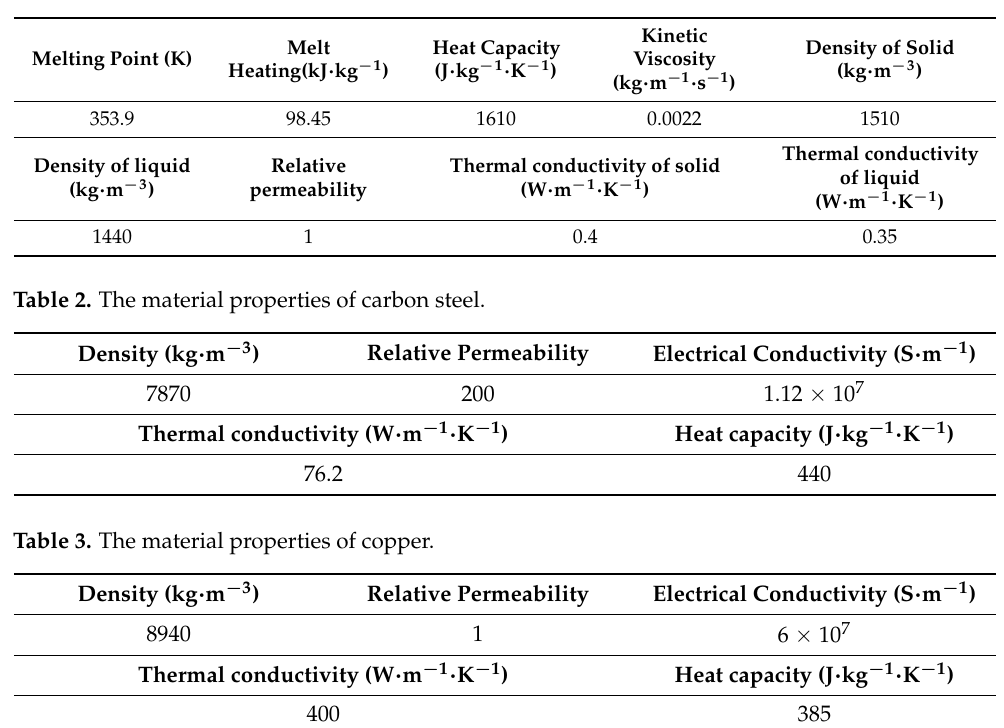
Table 1. The material properties of TNT.